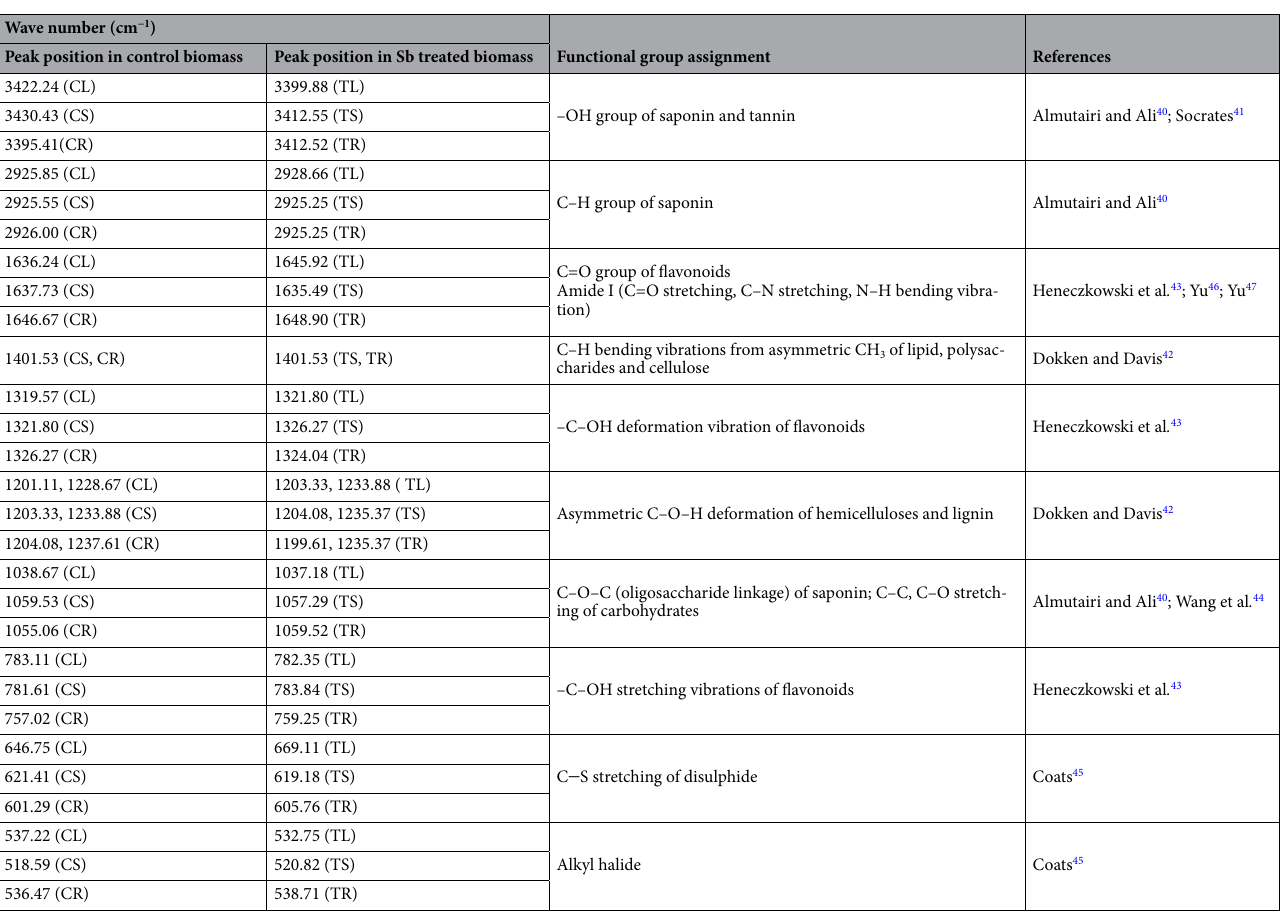
Table 2. Characteristic infrared absorption bands of various metabolites in the biomass of T. natans. CL control leaf, TL treated leaf, CS control stem, TS treated stem, CR control root, TR treated